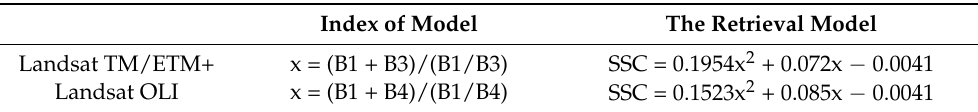
Table 1. The retrieval model of SSC in Poyang Lake; B1-B4 represents the band1-band4 of Landsat images (following Table 2).